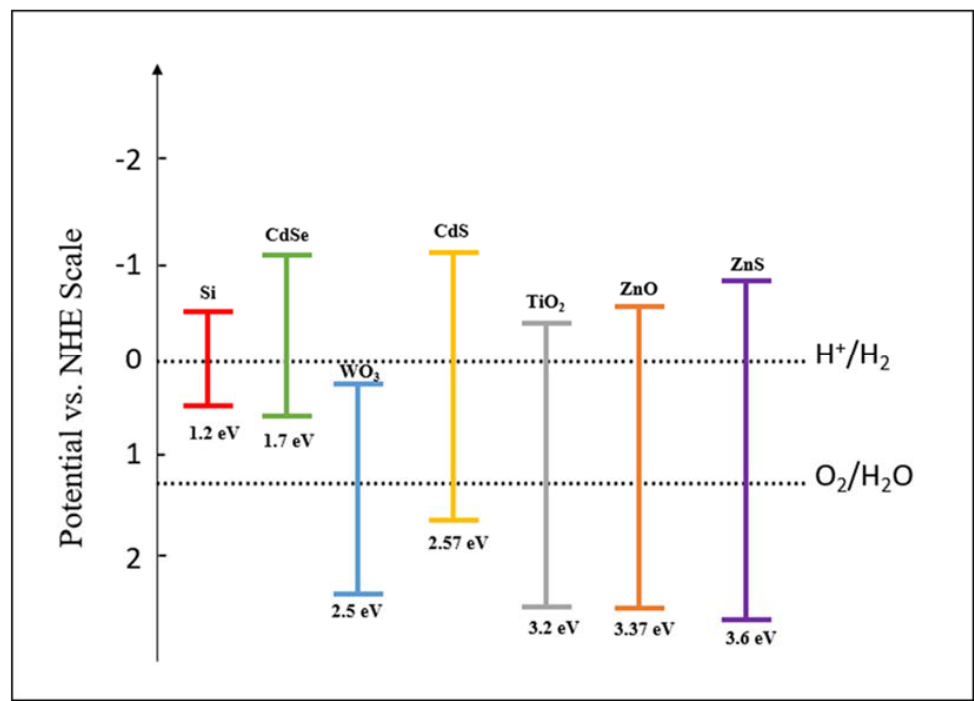
Figure 11. Bandgap potential diagram of semiconductors at normal hydrogen electrode.